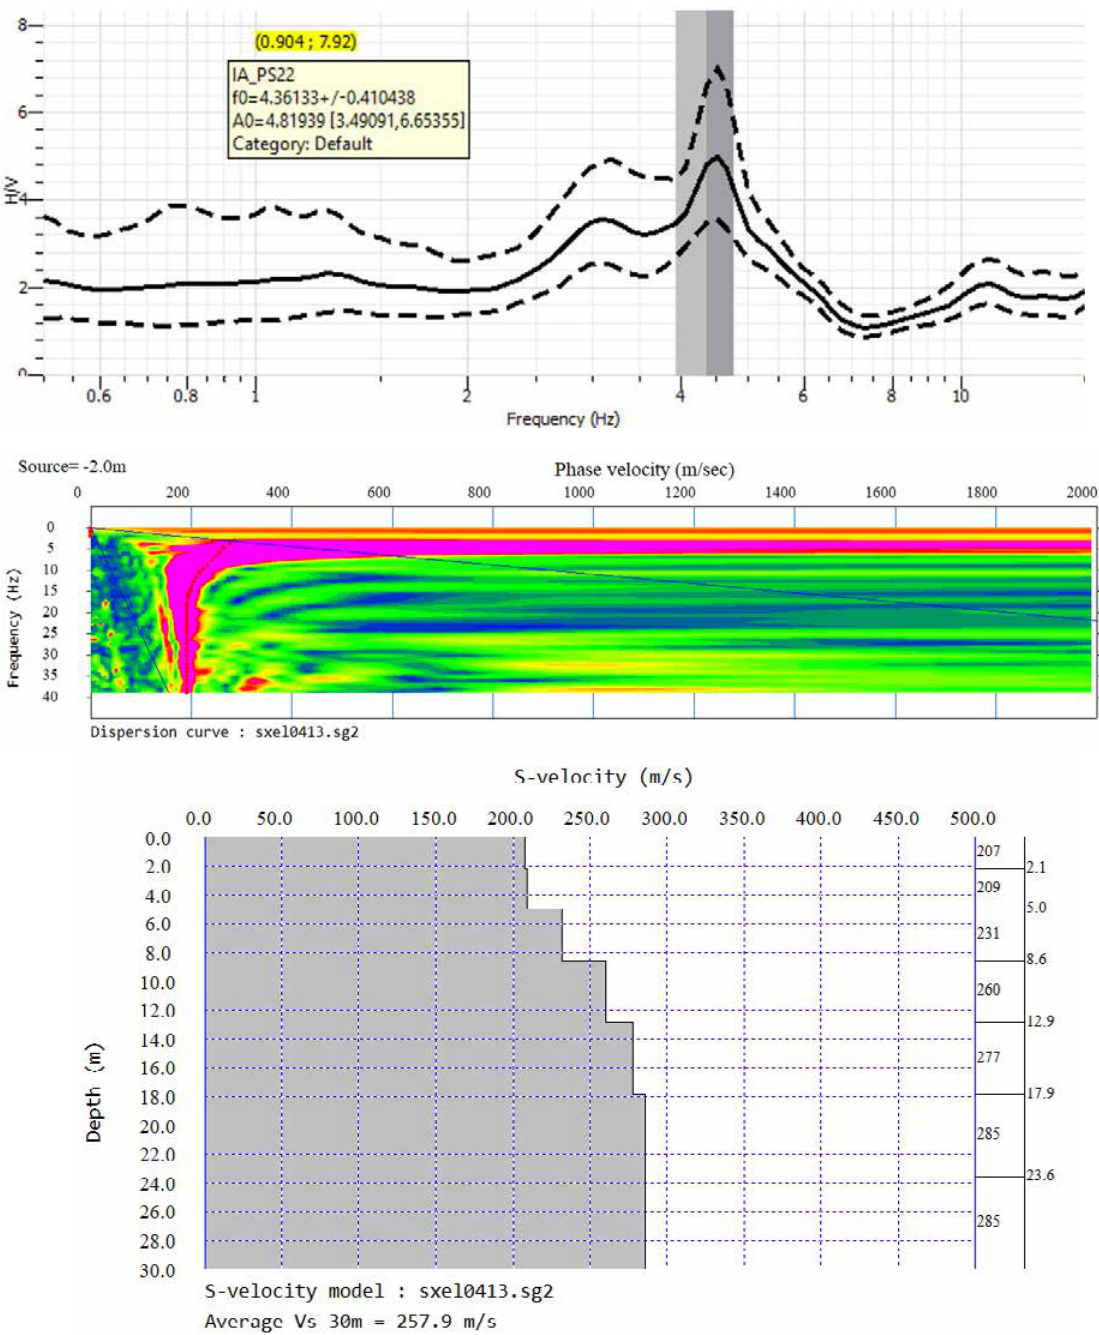
Fig. 3: HVSR of seismic microtremor at Point H020. The dominant frequency f 0 is the frequency when H/V is maximum (H/V) (TOP). Dispersion curve showing the relationship between phase velocity and frequency at location M040 (MIDDLE). Shear wave velocity model derived from the dispersion curve (BOTTOM).